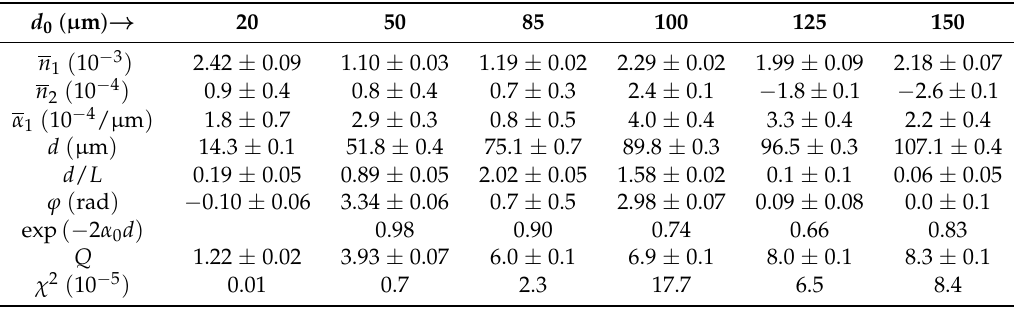
Figure 9. Angular dependencies of E 0, ± 1, ± 2 for a grating with ( a ) d 0 = 85 µ m and ( b ) d 0 = 125 µ m, t p = 12 s. Dashed lines are fits to the data based on numerically solving Equation (11). Table 2. Parameters obtained by fitting the angular dependence of the diffraction efficiency for various thicknesses.